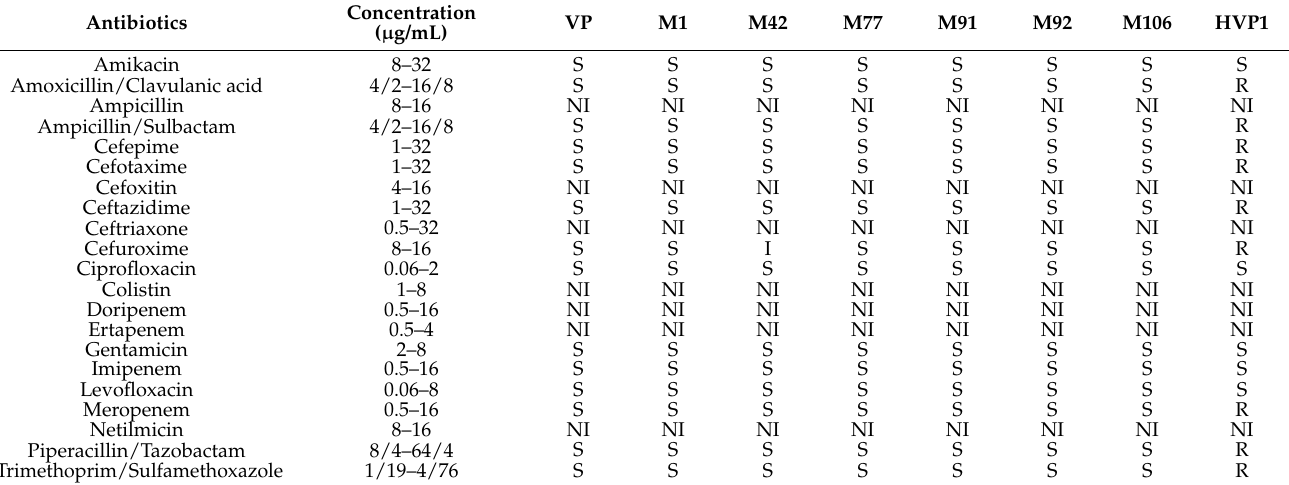
Table 4. Twenty-one antibiotics resistance profiles of V. parahaemolyticus isolates from Asian green mussel, clinical, and laboratory